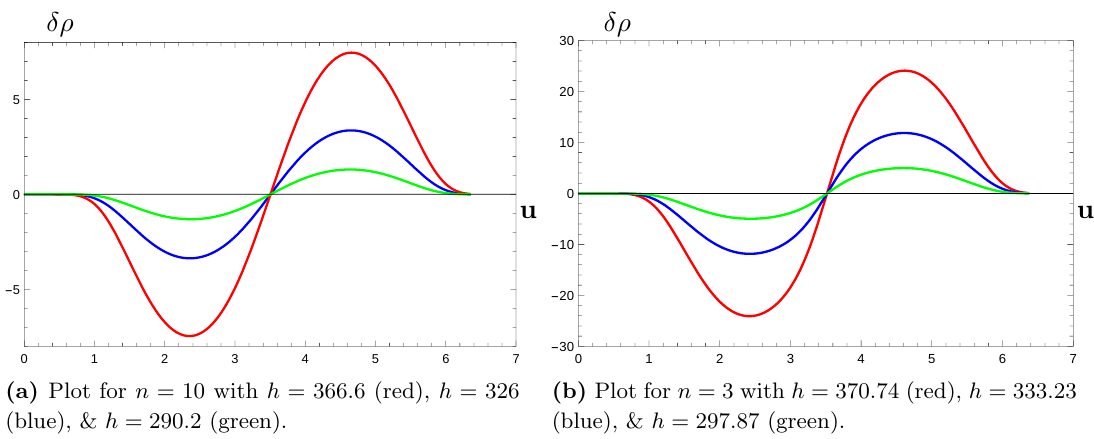
(a) Plot for n = 10 with h = 366 : 6 (red), h = 326 (b) Plot for n =3 with h =370 : 74 (red), h =333 : 23 (blue), & h = 290 : 2 (green). (blue), & h = 297 : 87 (green). Figure 9. Plot of (cid:14)t for n = 10 & 3 spikes for di(cid:11)erent h .